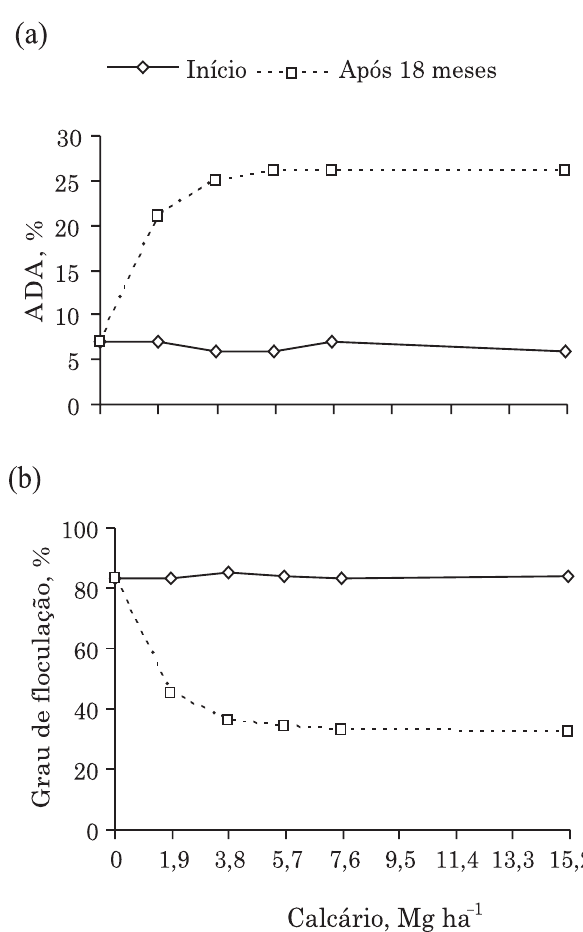
Figura 2. (a) Teores de argila dispersa em água (ADA) e (b) grau de floculação, na camada de 15 a 20 cm da coluna, no início e após 18 meses da incubação do solo com doses crescentes de calcário.